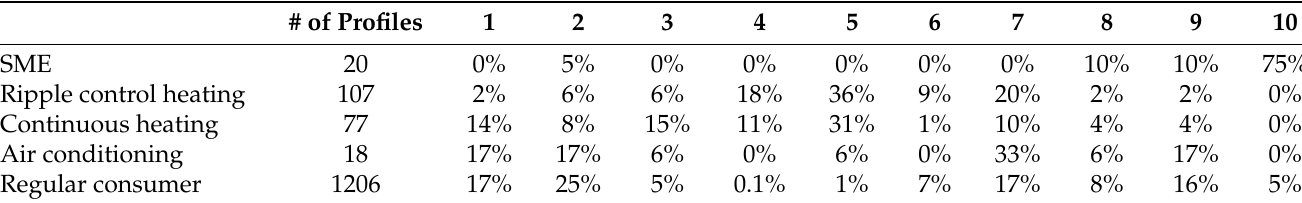
Table 4. Relative frequency of consumer categories over the 10 different clusters.